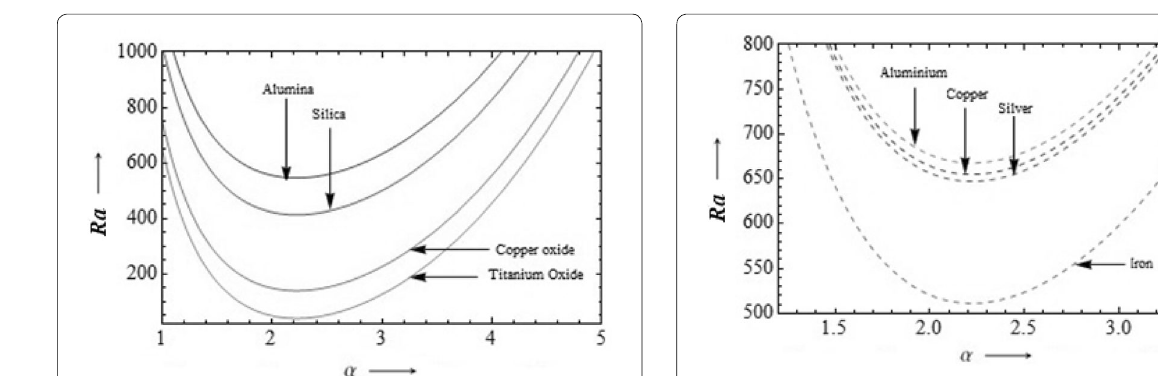
Fig. 4 Effect of metals on Rayleigh number